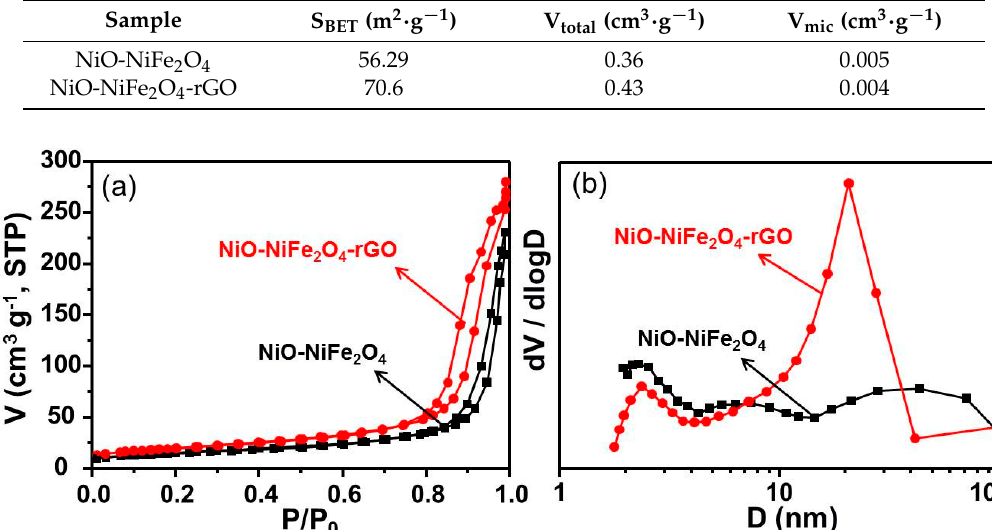
Figure 4. ( a ) N 2 adsorption-desorption isotherm. ( b ) Pore size distribution of NiO-NiFe 2 O 4 and NiO-NiFe 2 O 4 -rGO.